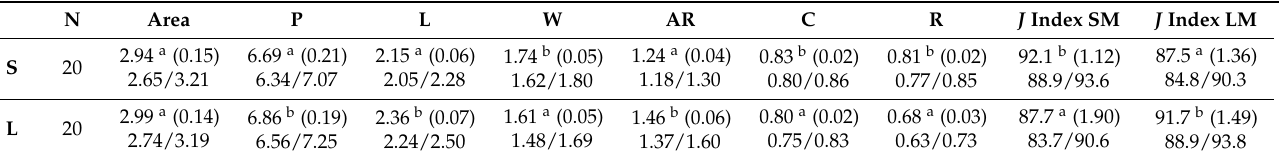
Table 3. Values of area, perimeter, length, width, aspect ratio, circularity, and roundness in two groups of short (S) and long (L) seeds in E. platyacanthus . J index SM and J index LM are the values of J index obtained with the short and long models, respectively. The mean values marked with the same superscript letter in each column do not differ significantly at p < 0.05 (Scheff é ’s test). N indicates the number of seeds analyzed.